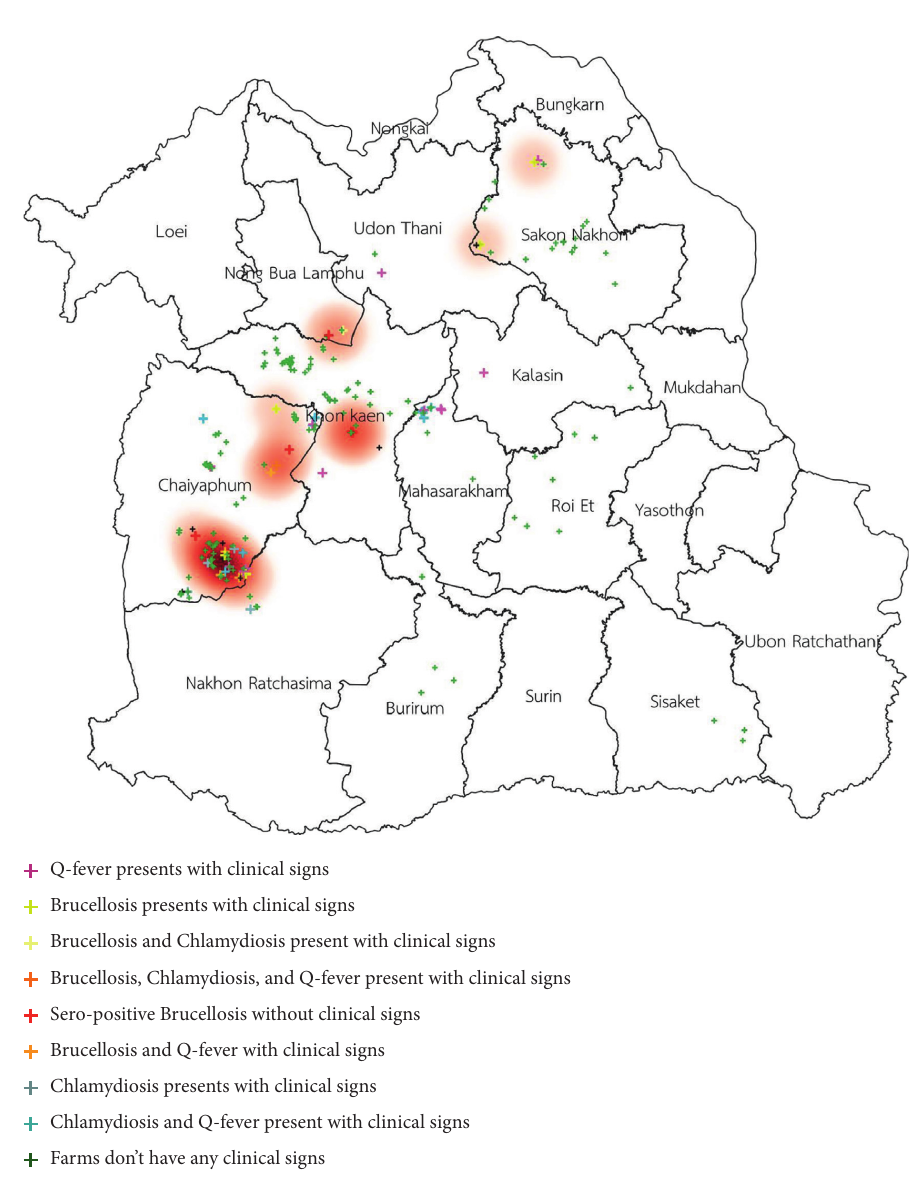
Figure 2: Distribution of clinical cases of brucellosis infection in smallholder meat goat herds in northeastern